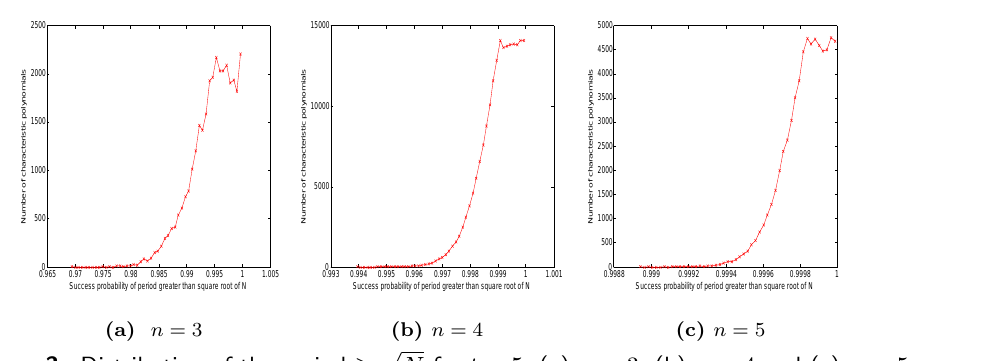
Figure 3. Distribution of the period ≥